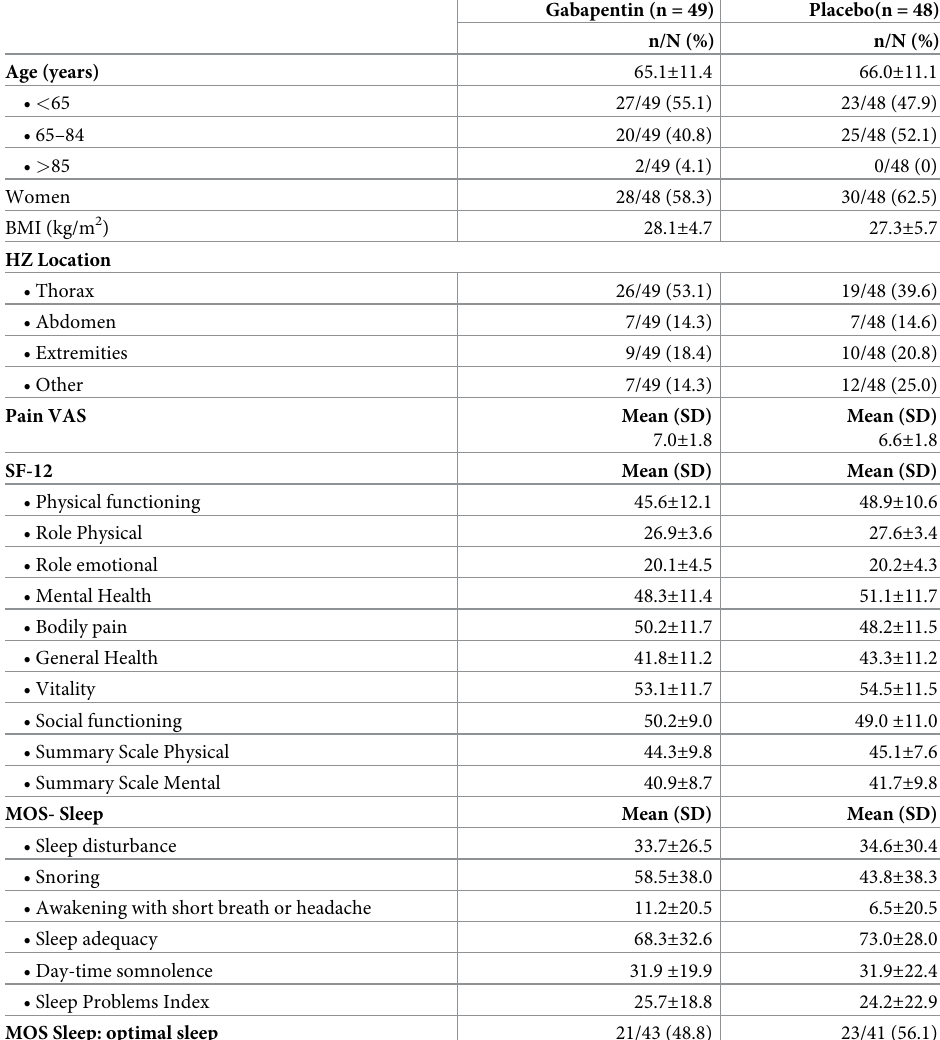
Table 1. Baseline characteristics of patients in the two